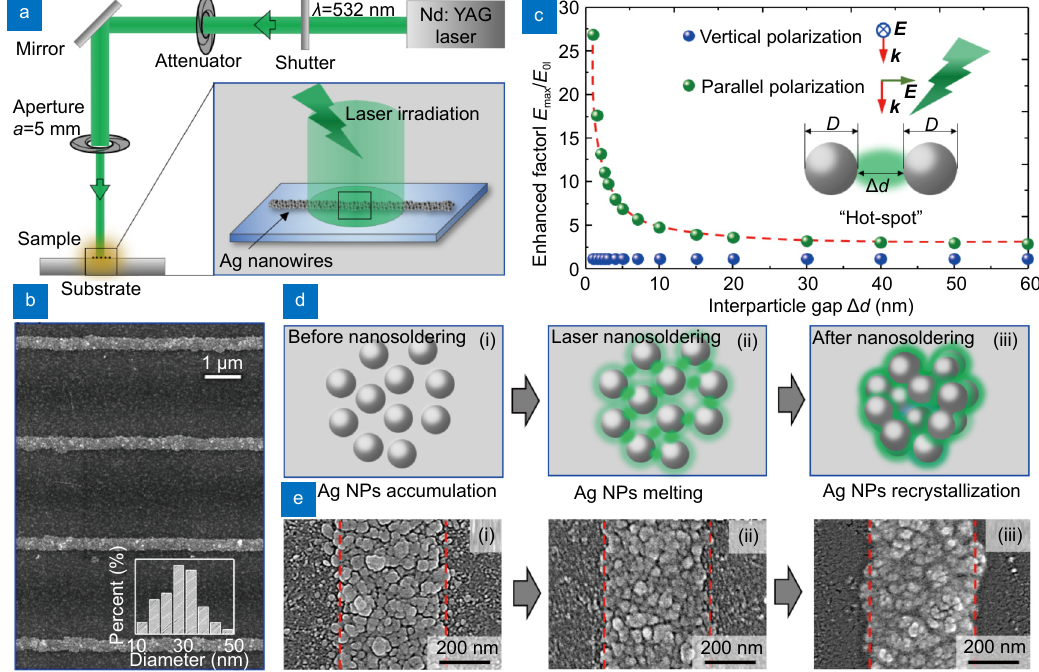
Fig. 1 | ( a ) Schematic of experimental system for PLNS. ( b ) Scanning electron microscope (SEM) image of Ag NWs with inset showing the size distribution of Ag NPs in Ag NWs. ( c ) Plasmon-enhanced electric field as a function of interparticle gap for light polarization direction parallel and vertical to the interparticle axis. ( d ) Schematic illustration of PLNS with increasing laser irradiation time. ( e ) SEM images of the morphological changes of Ag NWs in PLNS